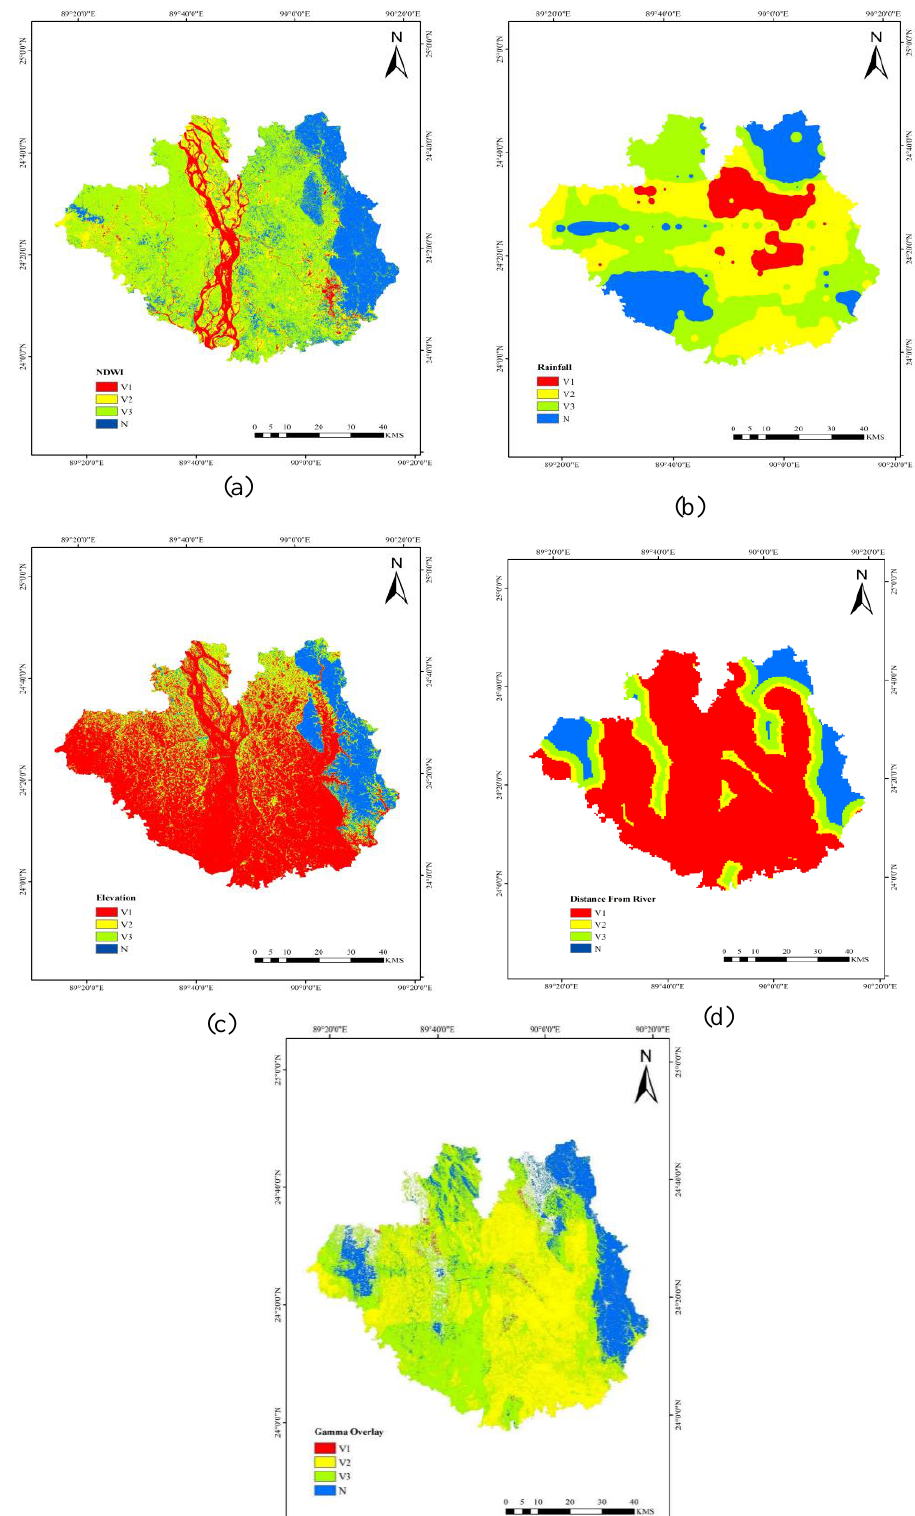
Figure 8. Reclassified vulnerability map of different indices: ( a ) NDWI; ( b ) rainfall; ( c ) elevation; ( d ) distance from river and ( e ) fuzzy gamma overlay, where V1, V2, V3 and N refer to high, moderate, marginal and nonvulnerable areas,